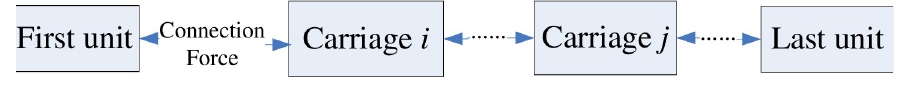
Fig 8. The calculation method of long-large train based on the loop